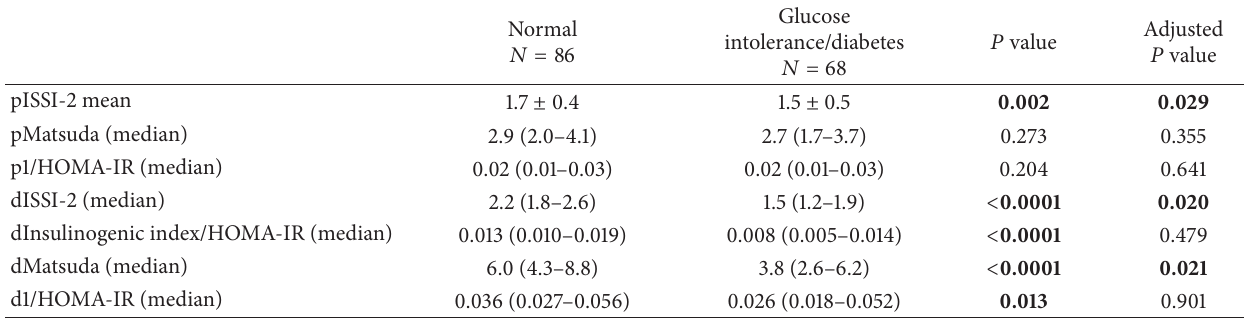
Table 3: Comparison of the beta-cell function and insulin sensitivity between women with a normal OGTT and women with glucose intolerance/diabetes